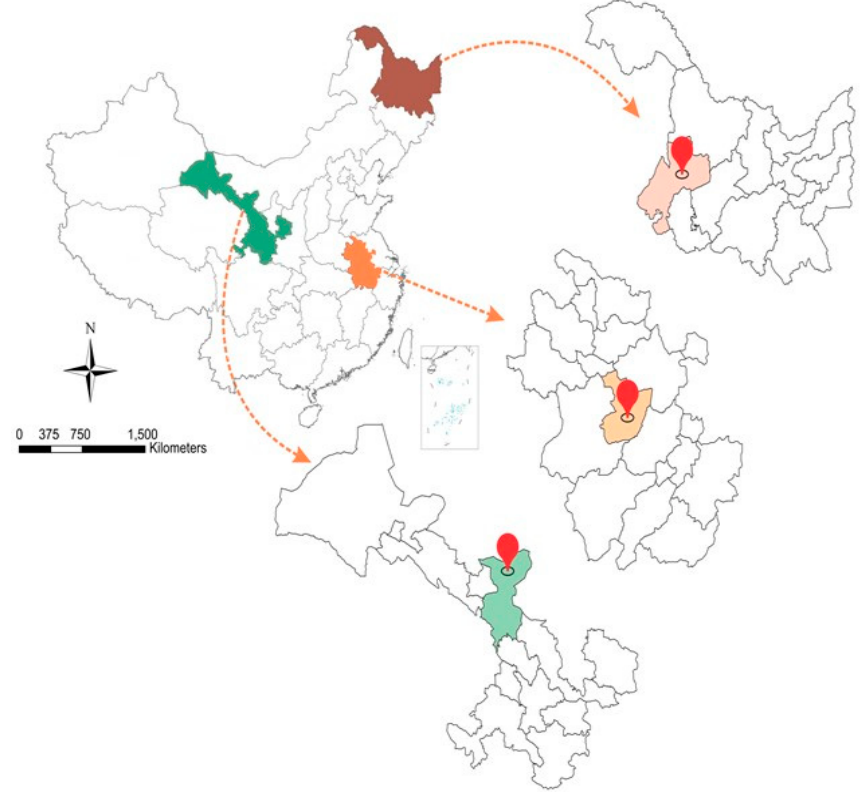
Figure 5. The map showing the purple (Mollisols), yellow (Vertisols), and green (Aridisols) soils of the Heilongjiang, Gansu and Anhui Provinces.